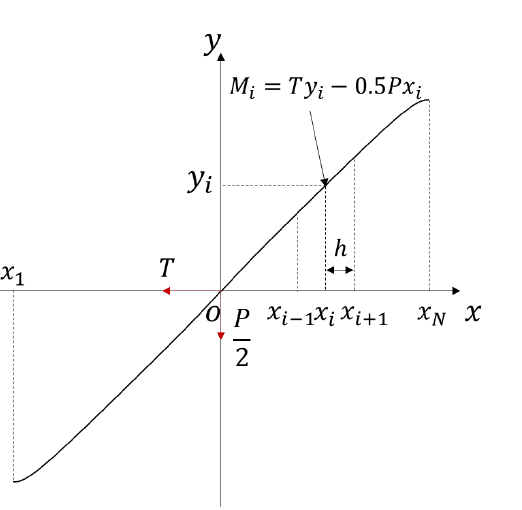
Figure 17. Differential schematic for the left half-span of the free bending strand.